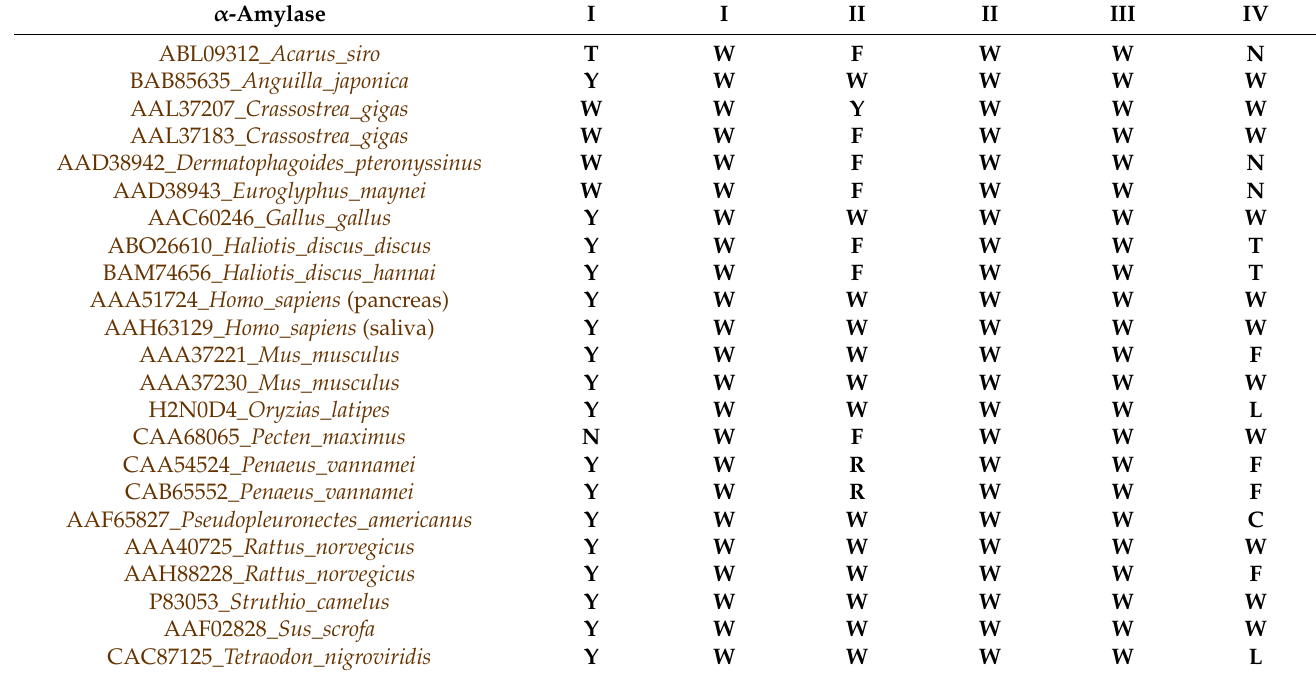
Table 4. Residues corresponding with the SBSs from H. sapiens α -amylase a